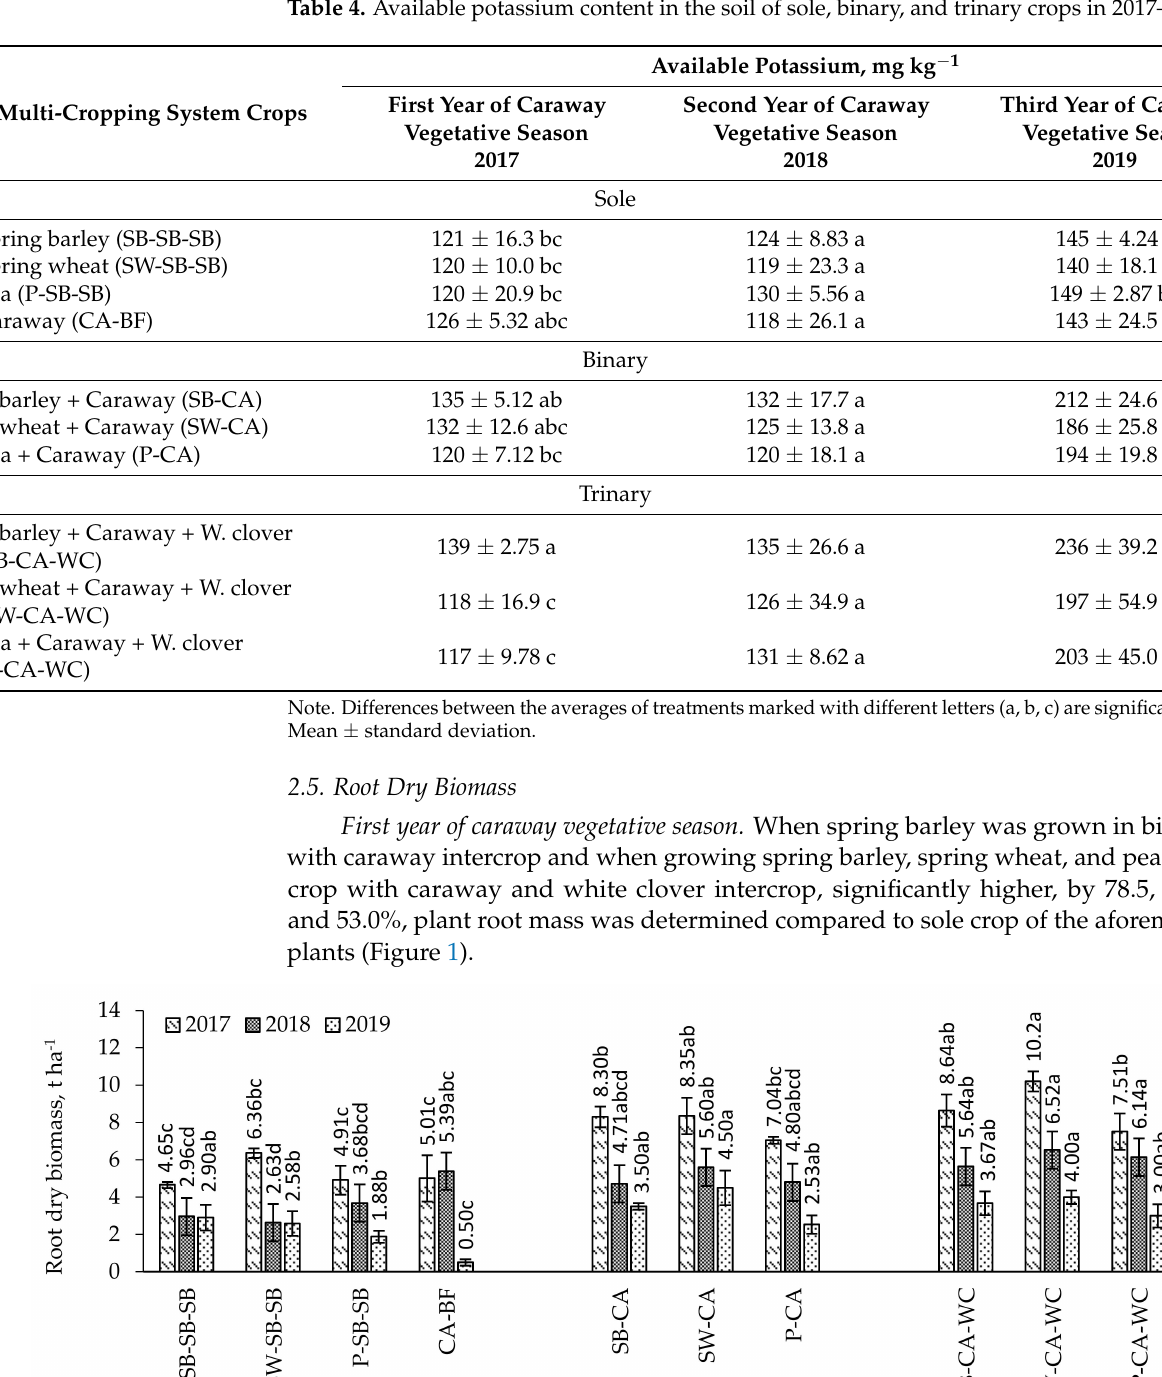
Table 4. Available potassium content in the soil of sole, binary, and trinary crops in 2017–2019.